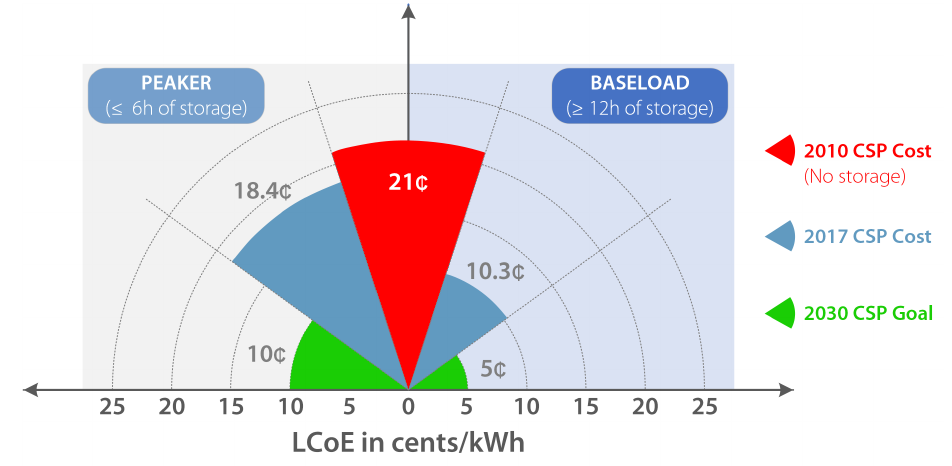
Figure 1. Progress and goals for Solar Thermal Electricity set by the SunShot programme. Data obtained from